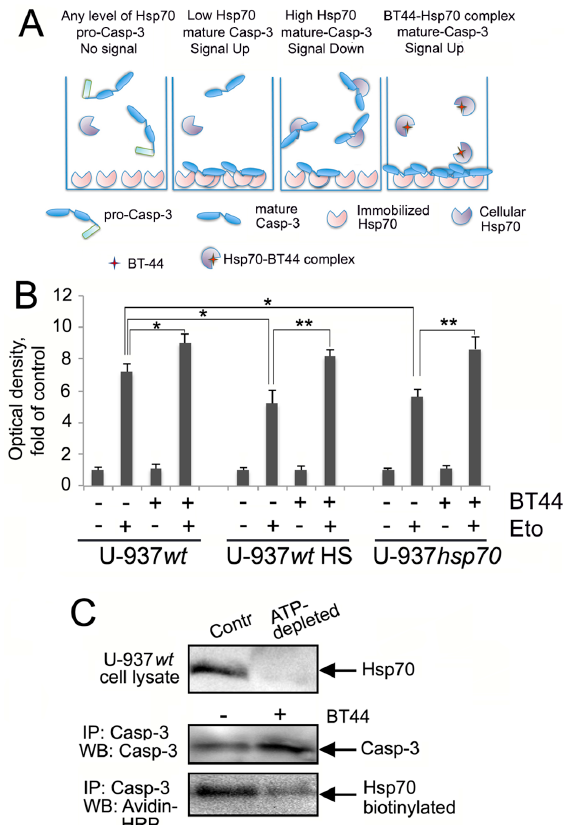
Figure 6. BT44 prevents binding of Hsp70 to Caspase-3 in etoposide-treated, Hsp70 over-expressing U-937 cells. ( A ) The scheme illustrating protein–protein interaction assay (Figure 6B). In cells with low levels of Hsp70 (U-937 wt and U-937 scr ), the number of chaperone molecules was not sufficient to trap all molecules of activated Caspase-3 which bound to Hsp70 immobilized on the well surface; BT44 induced destabilization of Hsp70 and Caspase-3 complex and made the enzyme molecules to stick to Hsp70 more efficiently, and signal was elevated. When cellular Hsp70 was overexpressed (U-937 wt after HS and U-937 hsp70 ), more molecules of activated Caspase-3 were bound to cellular Hsp70, less Caspase-3 was trapped by the immobilized chaperone, and signal decreased. Cellular Hsp70 was inactivated in the presence of BT44 so the number of activated Caspase-3 molecules available for trapping with the immobilized Hsp70 was elevated; ( B ) Competitive protein–protein interaction assay data. U-937 wt , control and after heat shock (43°C, 30 min, 6 h of recovery), and U-937 hsp70 , were treated with 50 µM BT44 and 1 µM etoposide, alone or in combination and the cell lysates were used for analysis. The plate was then incubated for 3 h. The data of four independent experiments is shown; A statistical difference was determined by a value of * p < 0.05, ** p < 0.01; ( C ) U-937 wt cells were treated with etoposide and 4 h later Hsp70 was depleted from cell lysate with the aid of ATP-agarose. After immunoprecipitation with anti-Caspase-3 antibody, gel slurry with Protein G-anti-Caspase-3 antibody and Caspase-3 was transferred to tubes containing pure biotinylated Hsp70 pretreated or not with BT44, and the gels with the proteins attached were subjected to electrophoresis and immunoblotting. The blot was stained using antibody to Caspase-3 and Avidin-peroxidase (Avidin-HRP). The data of two independent experiments is shown.